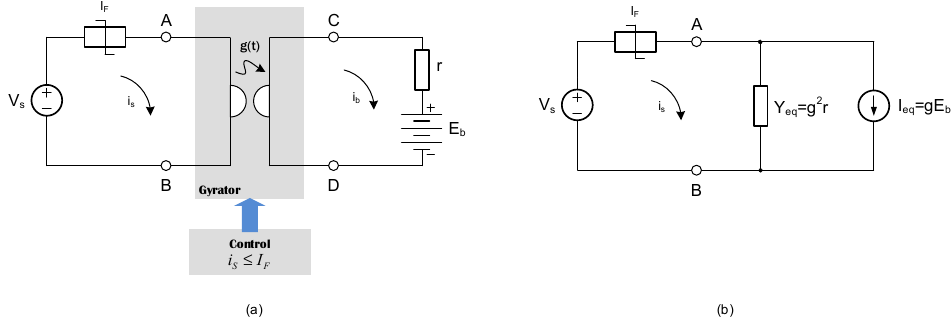
Figure 16. ( a ) Gyrator-based battery charger. ( b ) The equivalent circuit.